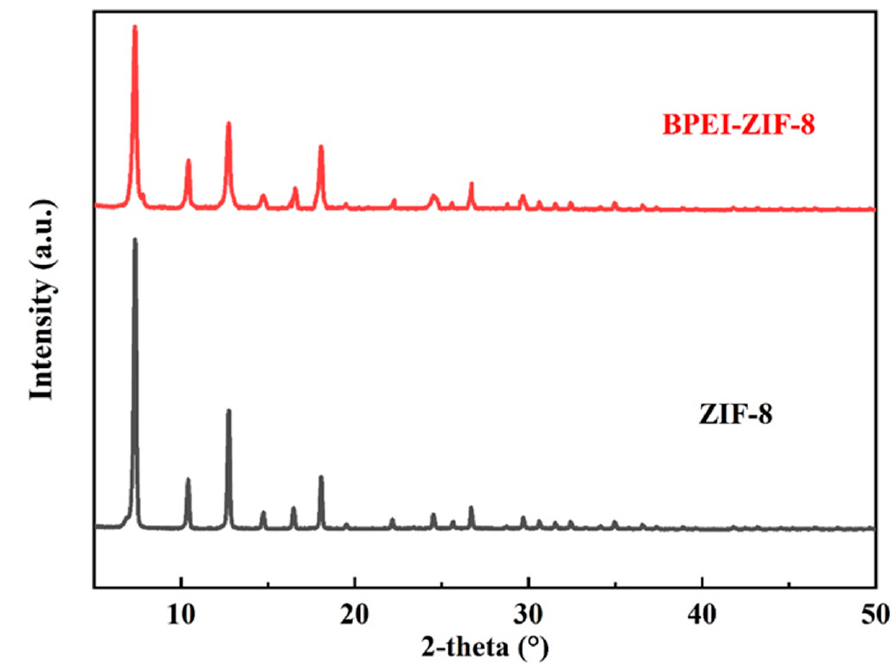
Figure 1. XRD spectra of ZIF-8 and BPEI-ZIF-8.